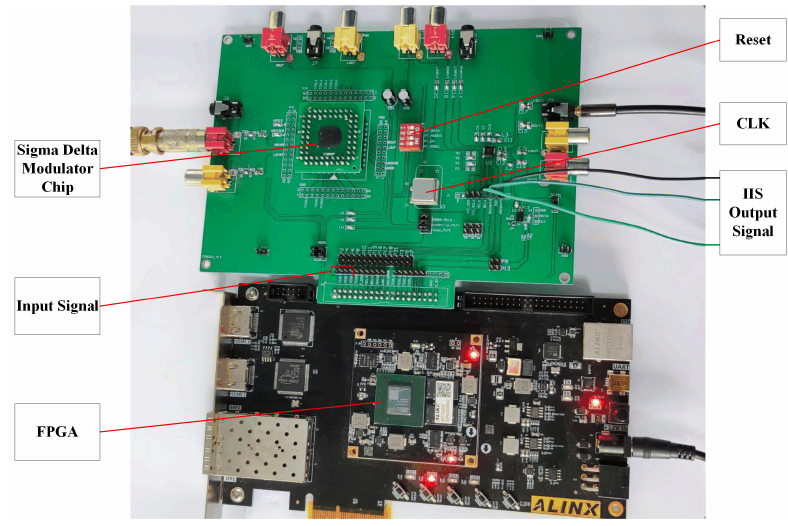
Figure 8. Photograph of the FPGA verification platform.